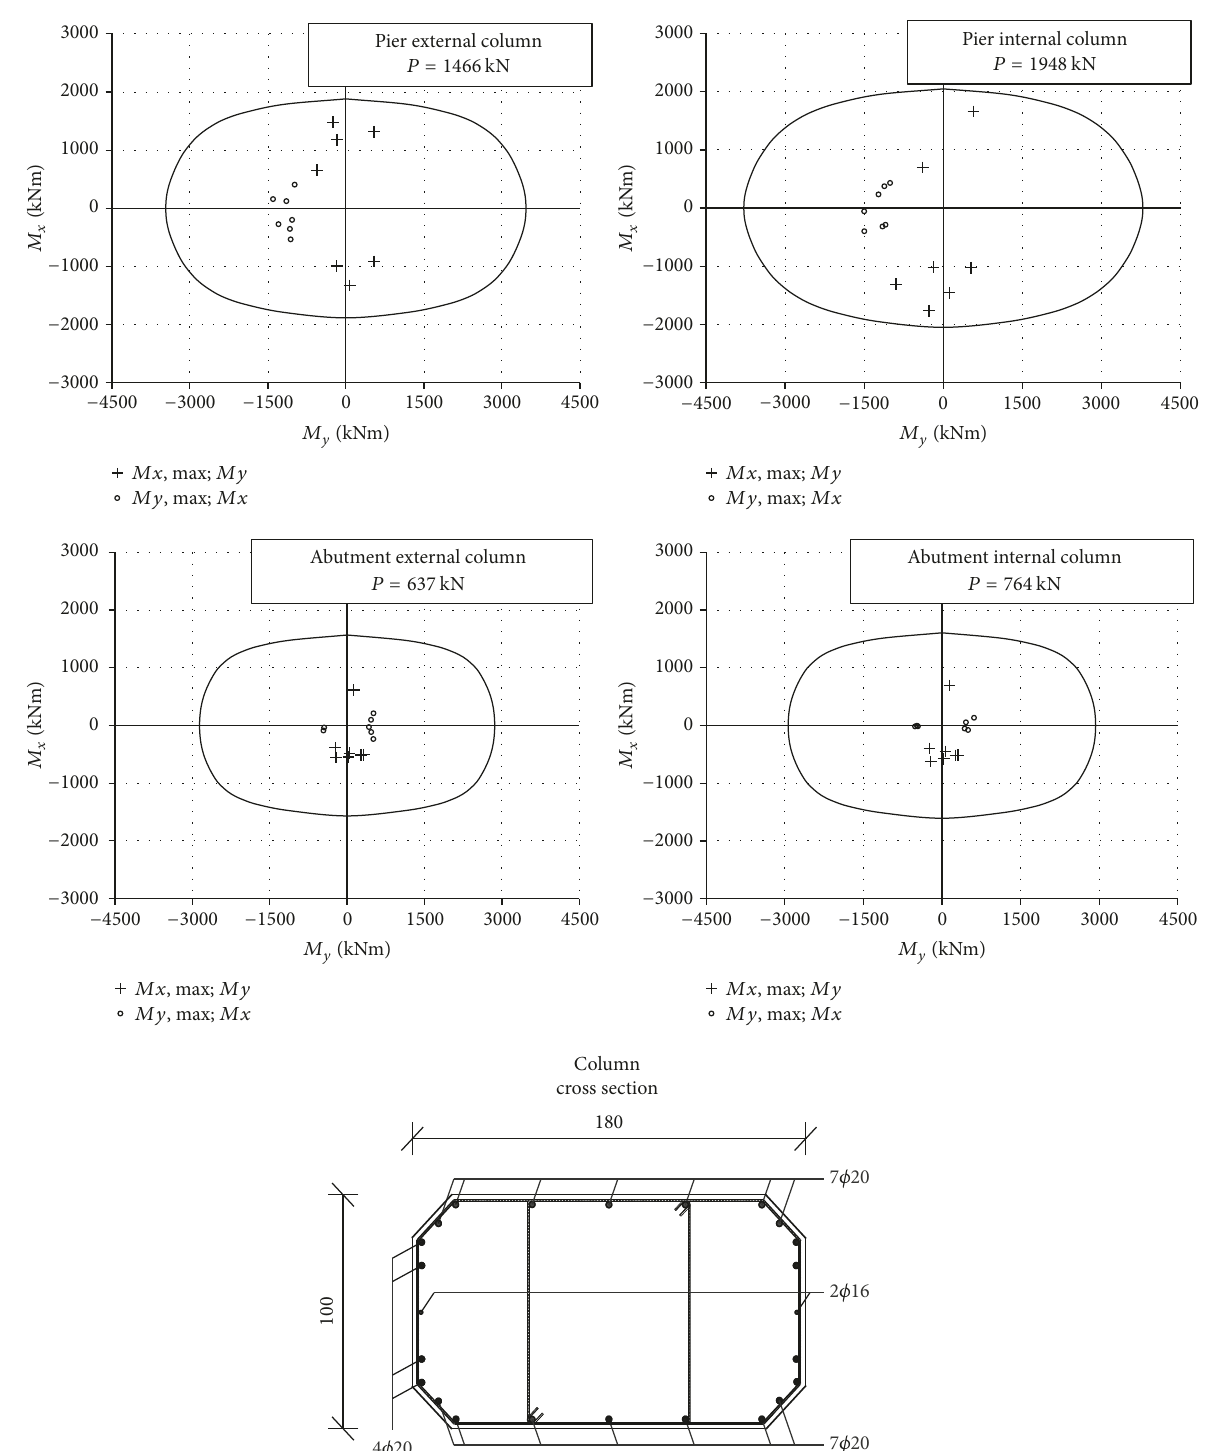
Figure 16: Safety check of the cross section at the base of internal and external columns of piers and abutments.